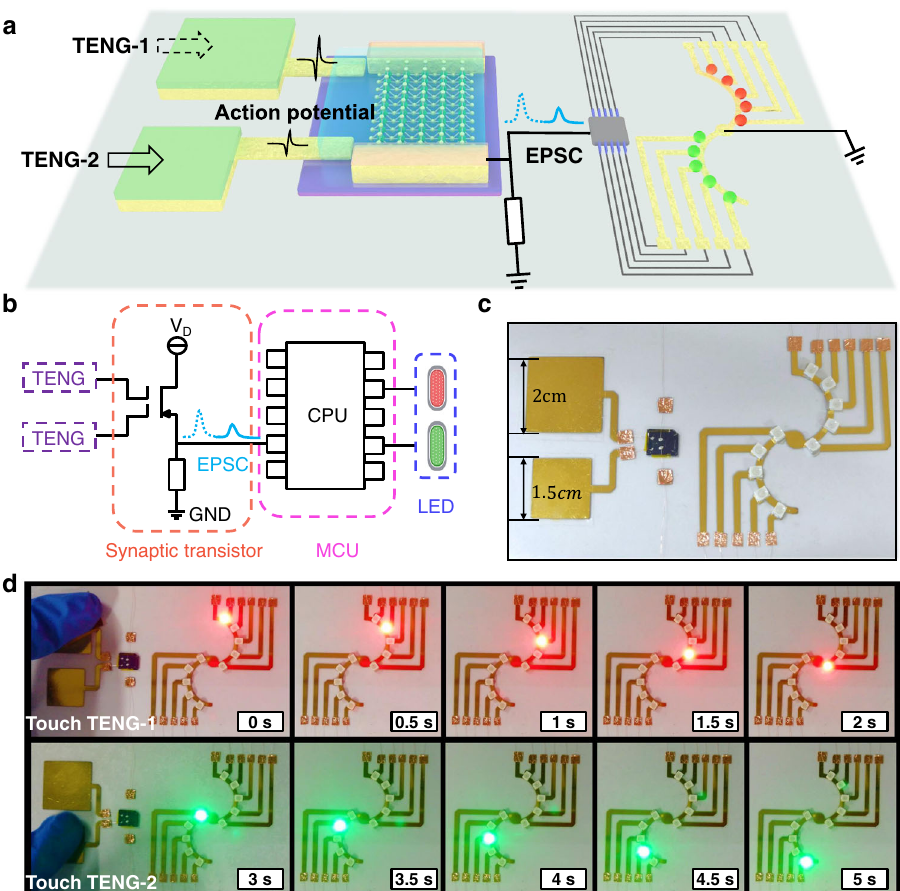
Fig. 5 Demonstration of the dynamic logic of the CE-activated arti fi cial afferent. a Schematic illustration diagram, ( b ) a simpli fi ed circuit diagram, and ( c ) a photo of the arti fi cial afferent for dynamic logic demonstration. d Red LEDs triggered by CS action from TENG-1 (top) and green LEDs triggered by CS action from TENG-2